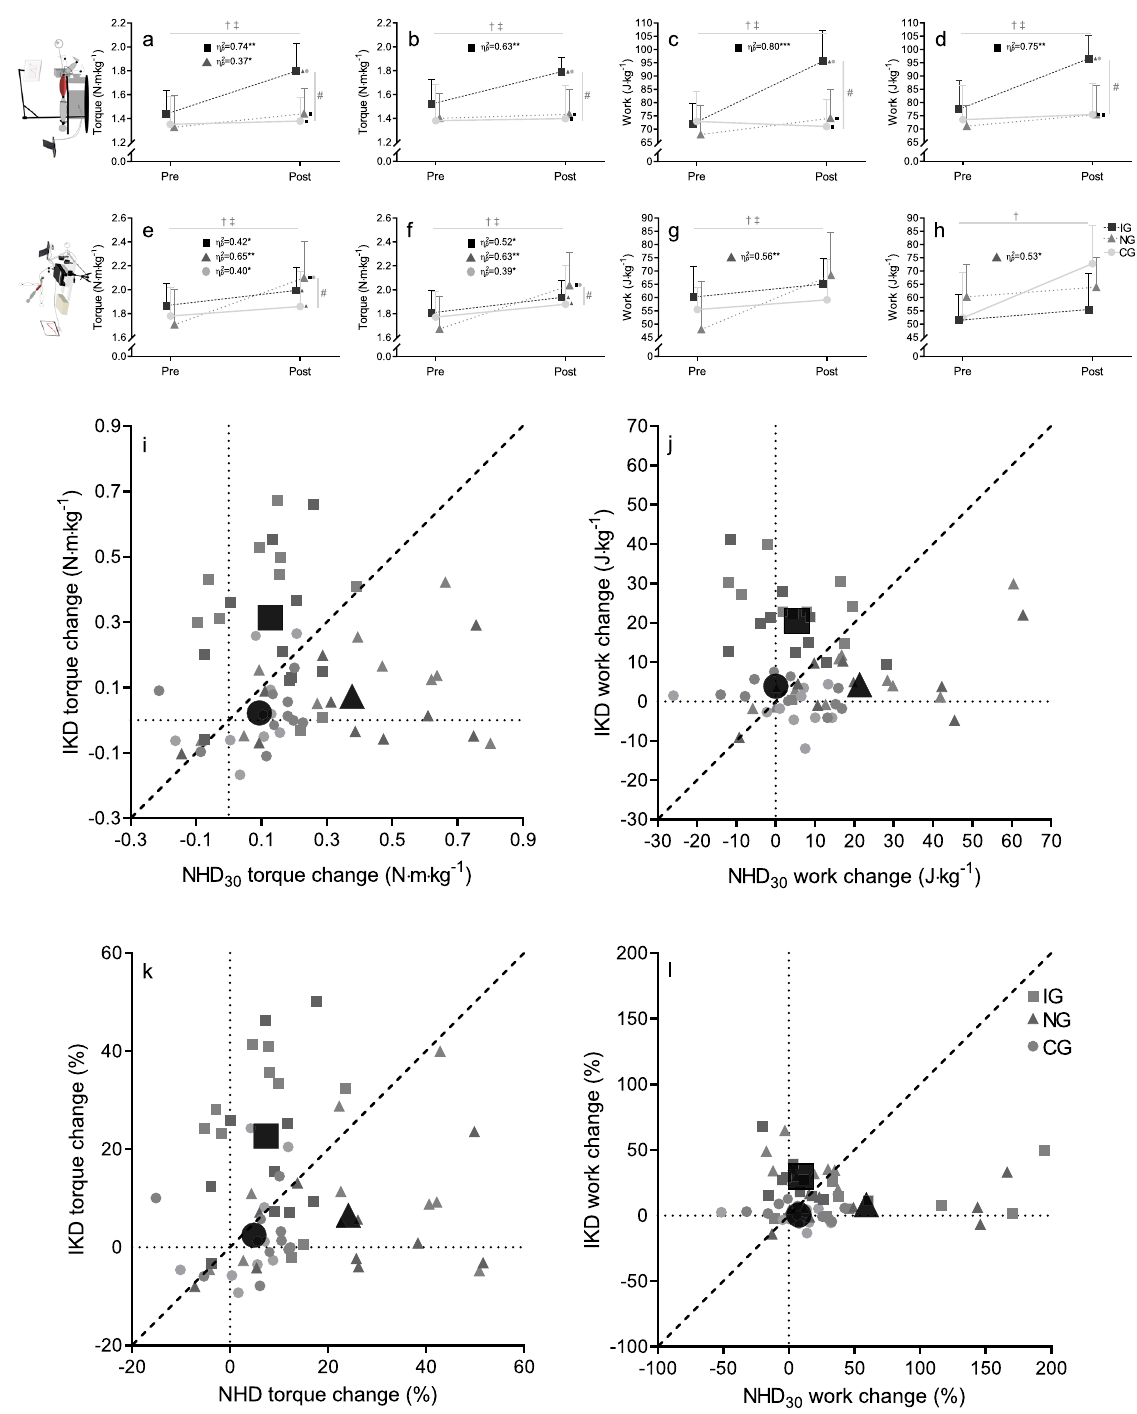
Figure 3. Pre- and post-performance in eccentric torque and work measured with the isokinetic device (left: a , c ; right: b , d ) and the Nordic hamstring device (left: e , g ; right: f , h ) and the relation of obtained torque ( i , k ) and work ( j , l ) changes over time. Values are mean ± SD. IG, isometric group; NG, Nordic hamstring group; CG, control group; IKD, isokinetic device; NHD 30 , Nordic hamstring test at a lean forward velocity of ~ 30°·s- 1. # for the significant group effect, with post-hoc differences between groups shown by squares (significantly different from IG), triangles (significantly different from NG), and circles (significantly different from CG); † for the significant time effect; ‡ significant interaction effect. Further, each subgroup was analysed independently (paired sample t-test); *, P < .05, **, P < .01, ***, P <